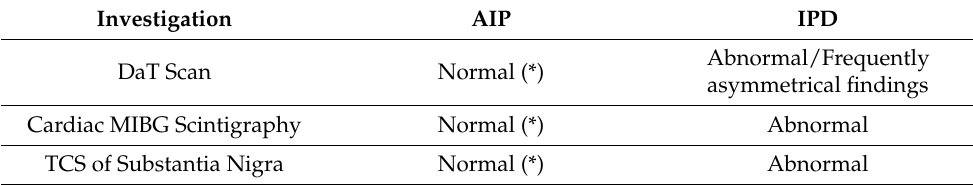
Table 6. Investigation findings in DIP vs. IPD.